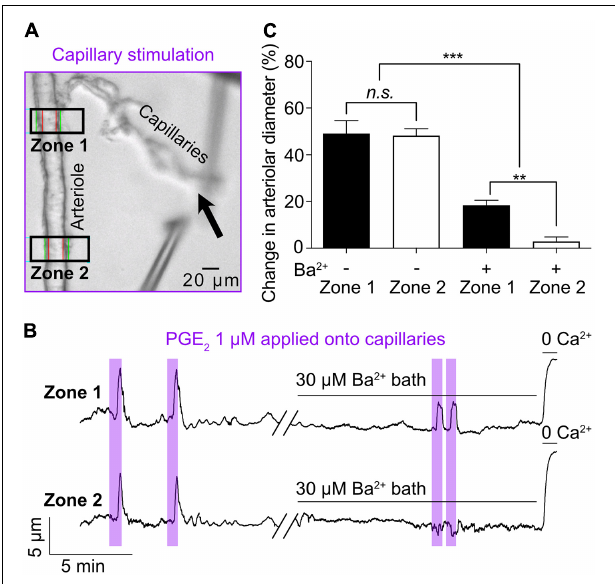
FIGURE 2 | Kir channel blocker Ba 2 + (30 µ M) inhibits the propagation, not the initiation, of the PGE 2 -induced upstream arteriolar dilation. (A) Micrograph showing Zone 1 and Zone 2 positions for arteriolar diameter recording during capillaries stimulation (black arrow) with 1 µ M PGE 2 . (B) Representative traces of arteriolar diameter at zone 1 and zone 2 showing the effect of 30 µ M bath-applied Ba 2 + on PGE 2 -induced upstream dilation. (C) Summary data from 5 mice ( n.s. , not significant; ** P < 0.01, *** P < 0.001, one-way ANOVA, Tukey’s test).